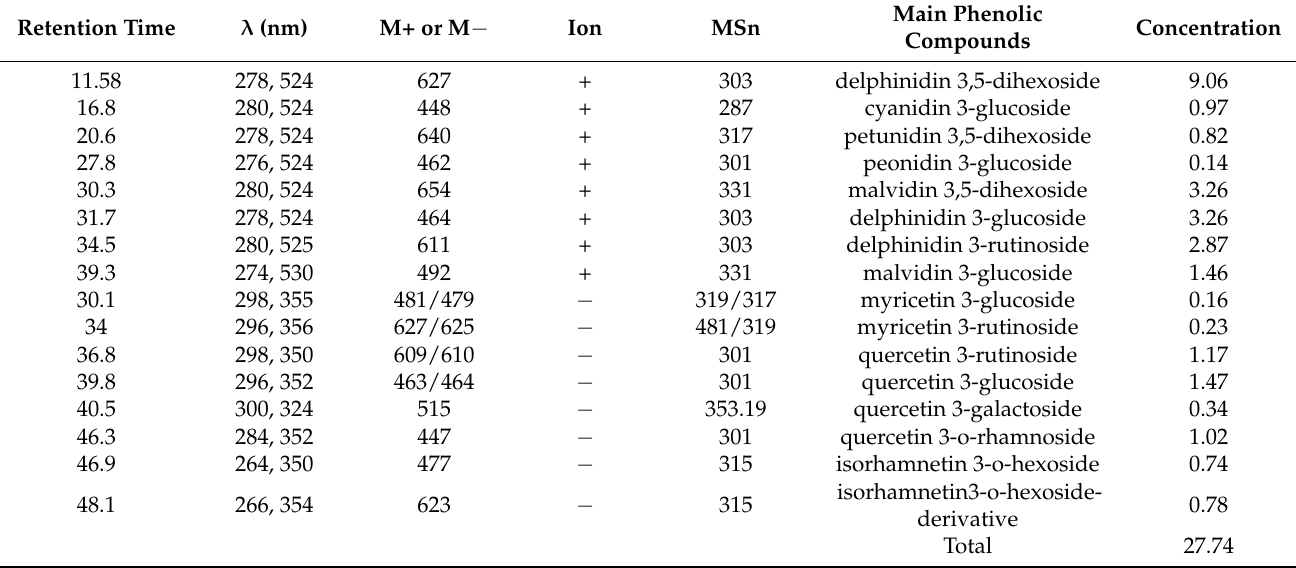
Table 2. Phenolic compounds in calafate fruit extract (Berberis microphylla G. Forst) identified and quantified by HPLC-DAD-